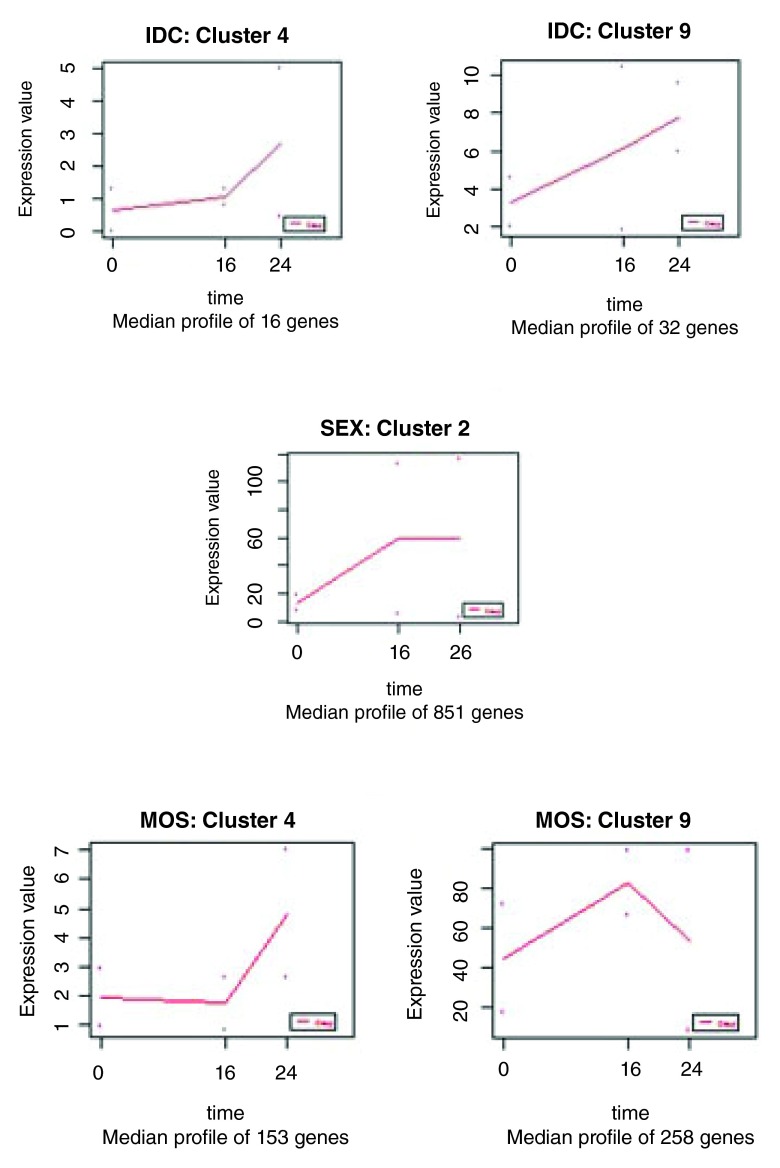
Selected median expression profiles of the clusters of the IDC (cluster 4 and cluster 9), SEX (cluster 2), and MOS (cluster 4 and 9) showing the number of genes of each gene-set.